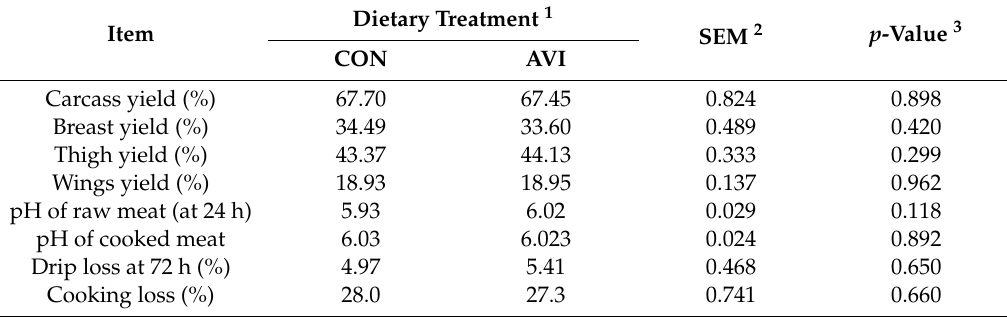
Table 2. E ff ect of dietary treatment on slaughter performances, drip loss, cooking loss and pH of raw and cooked